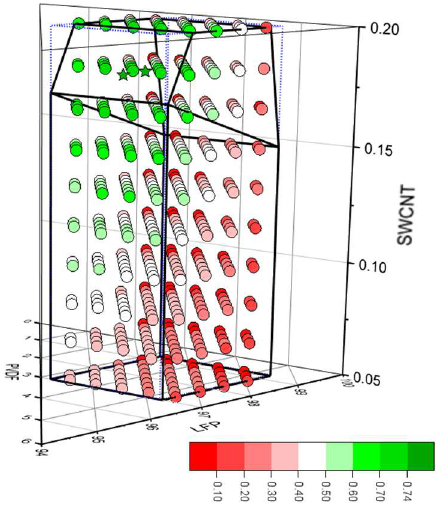
Figure 8. Desirability scores for the four-parameter model.